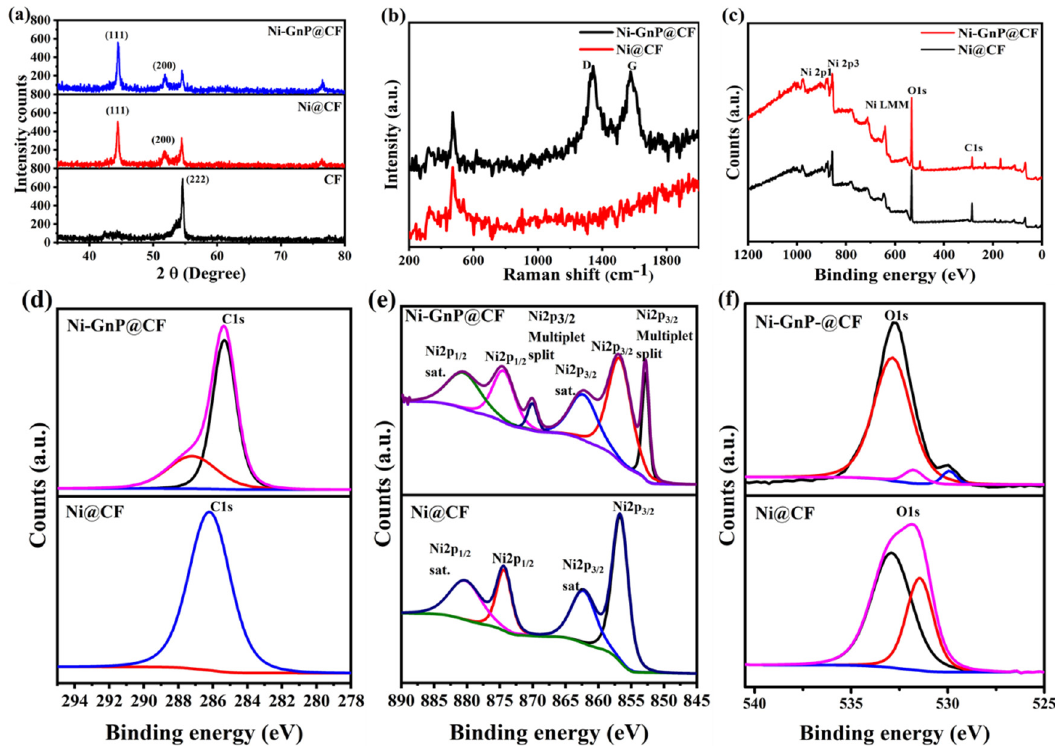
Figure 3. ( a ) XRD patterns of CF, Ni@CF, and Ni-GnP@CF, ( b ) Raman spectra of Ni@CF and